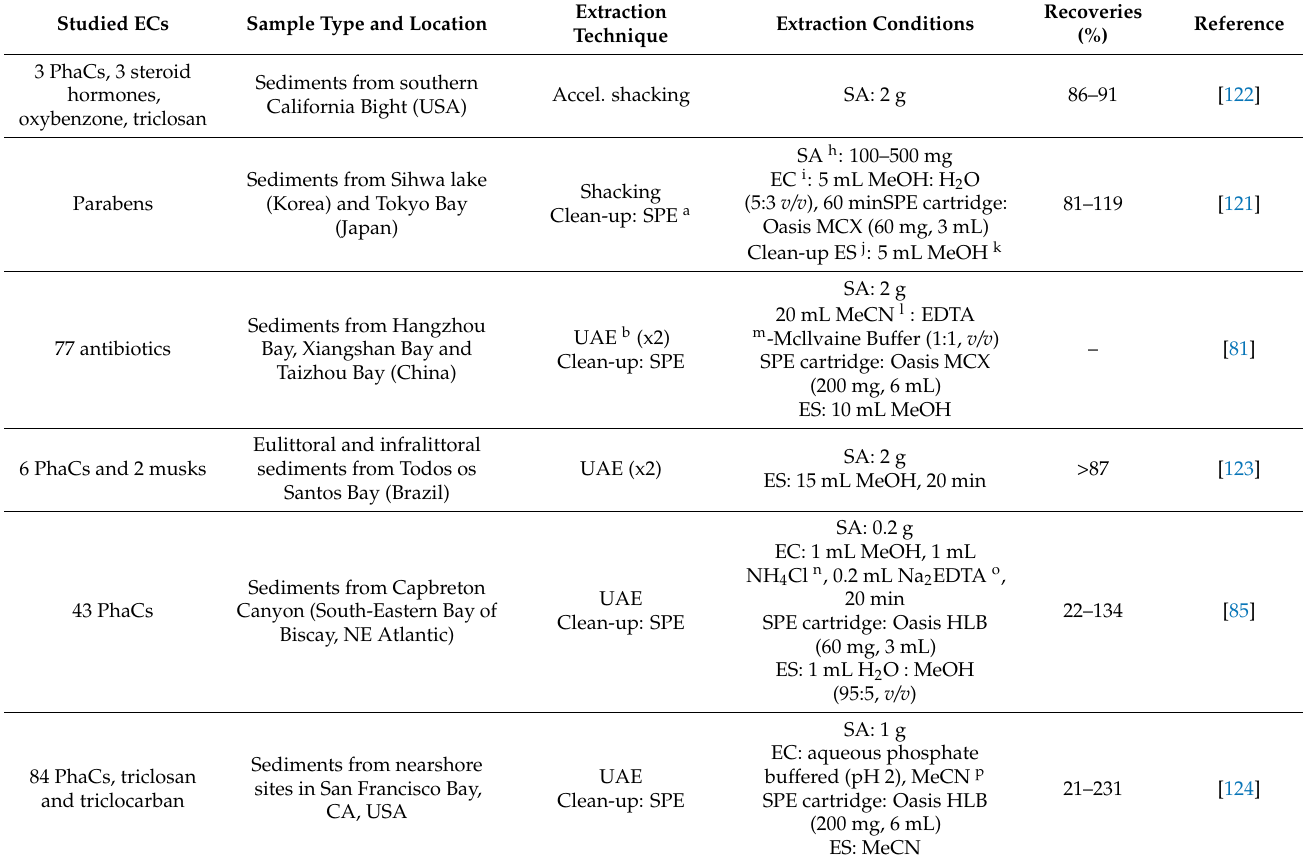
Table 5. Extraction methodologies for PPCPs present in coastal solid